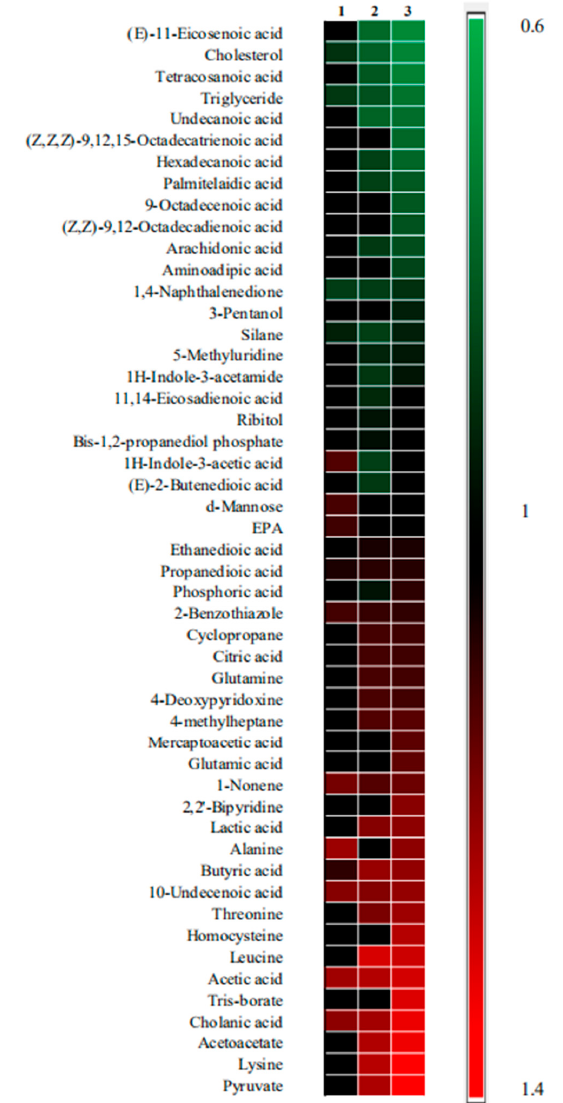
Figure 5. The heatmap of three drug treatment groups compared with the model group. Metabolites with significant differences could be selected according to the criteria of the variable importance in the projection (VIP) > 1.0 and p < 0.05 in the t-tests. Moreover, 1 represents the ursolic acid group vs. model group. Furthermore, 2 represents the artesunate group vs. the model group and 3 represents the combination group (ursolic acid and artesunate) vs. the model group. Shades of red represent the fold of metabolite increase compared with the model group; green shades represent the fold of metabolite decrease compared with the model group, respectively. Moreover, black shades represent no significant change in the fold of the metabolite compared with the model